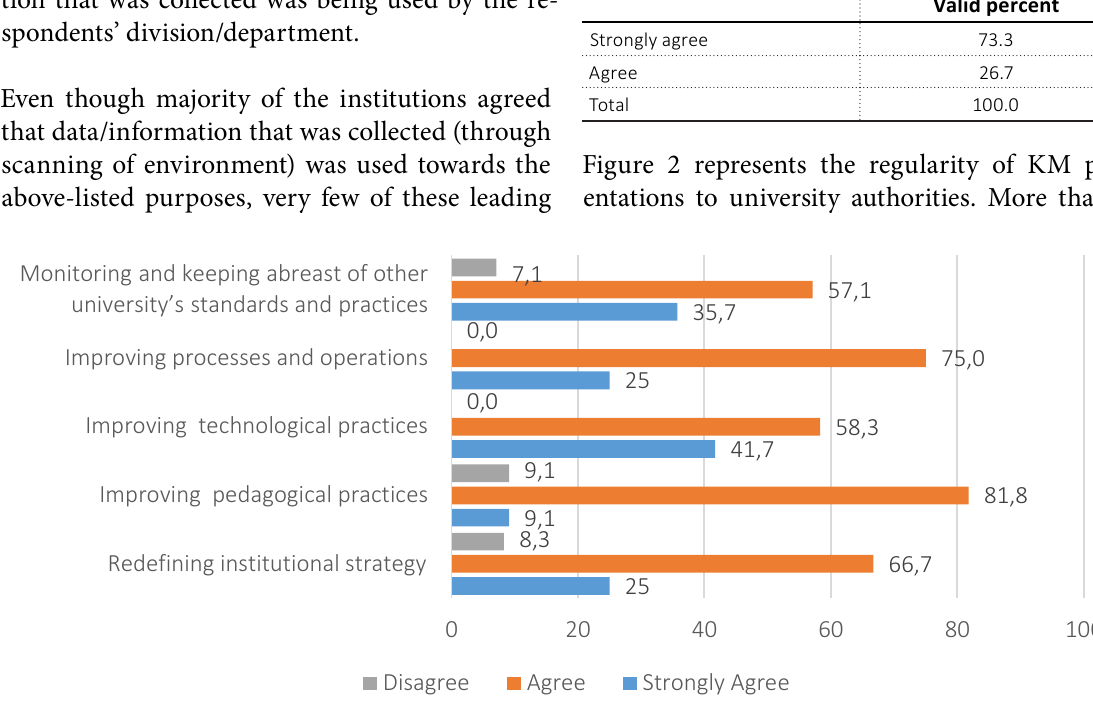
Figure 1. How collected data/information is being used by the respondents’